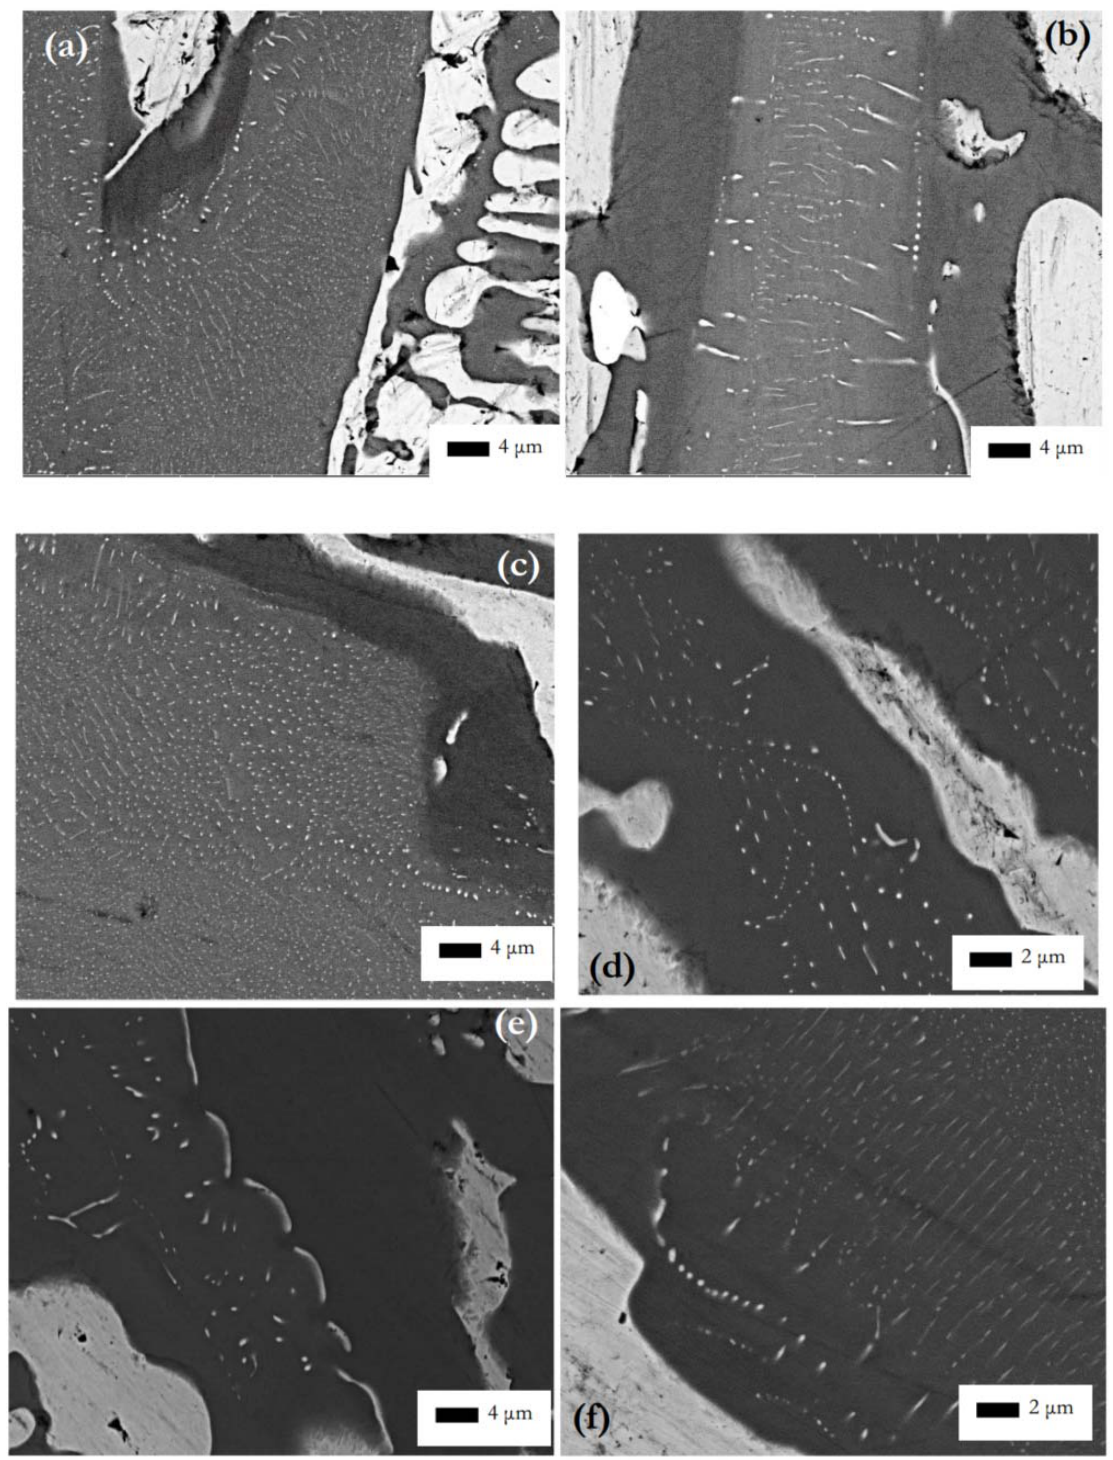
Figure 4. Backscattered electron images showing regions of light contrast, including precipitates, within the silicide phase in CM1-OFZ for the growth rates of ( a ) 150, ( b ) 60, ( c ) 12 and ( d ) 150, ( e ) and (f ) 12